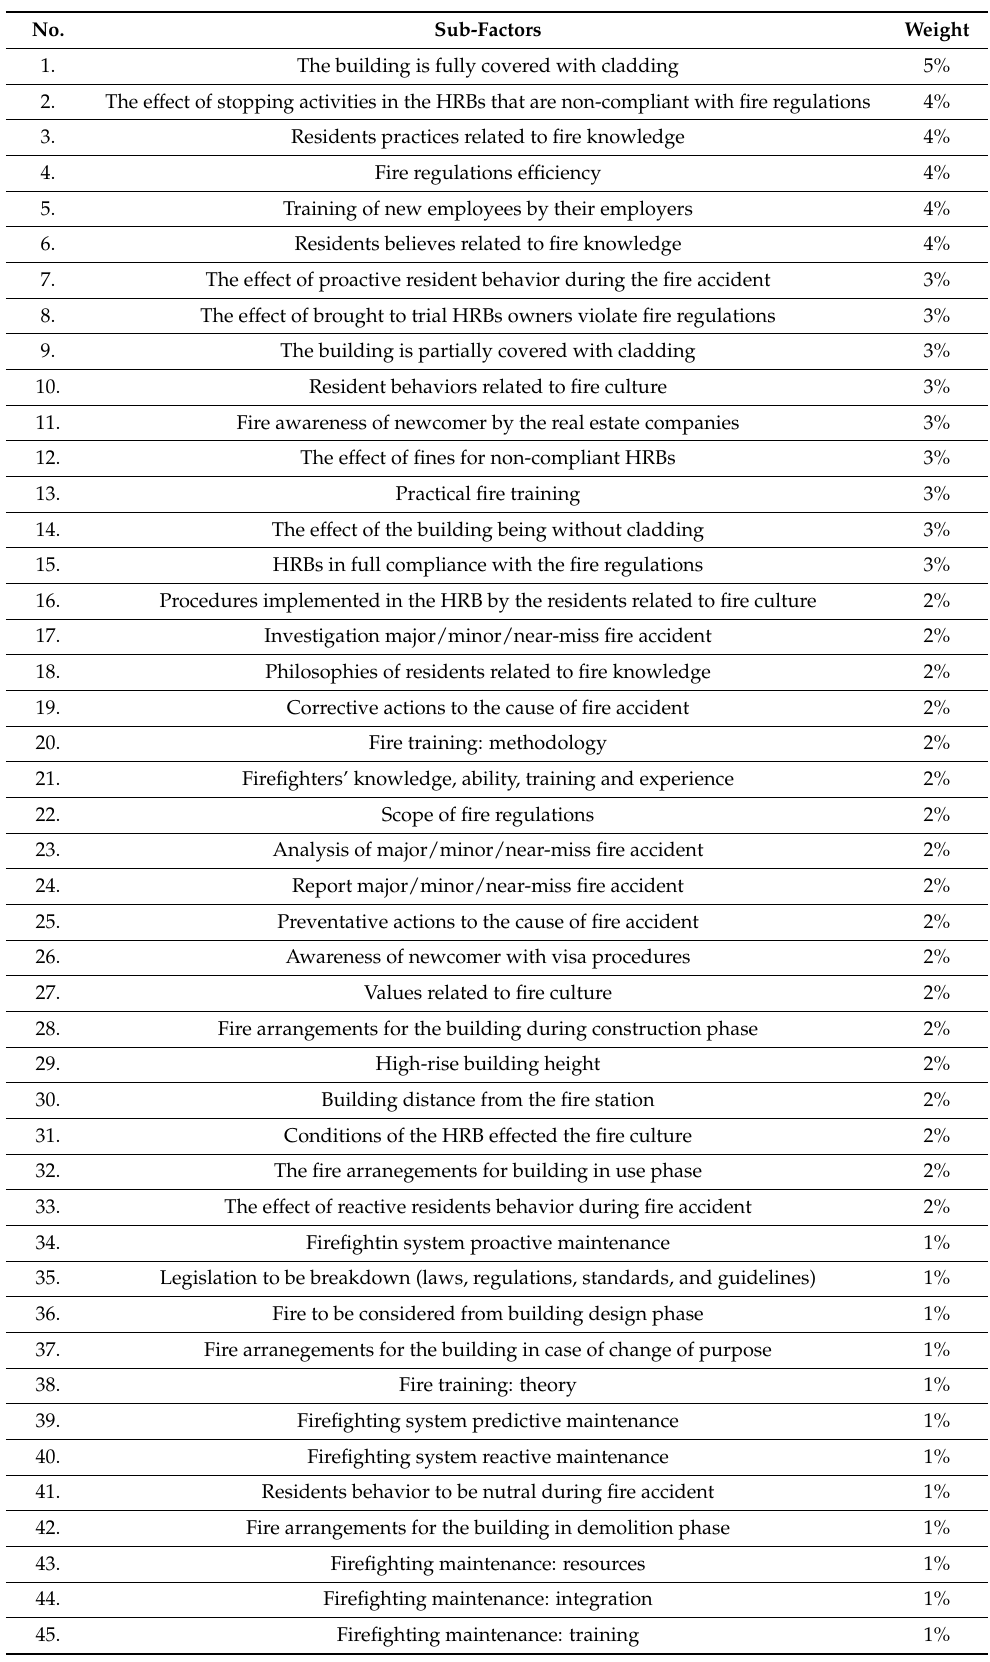
Table 9. Sub-critical factors effecting the fire management in the HRBs in the Emirate of